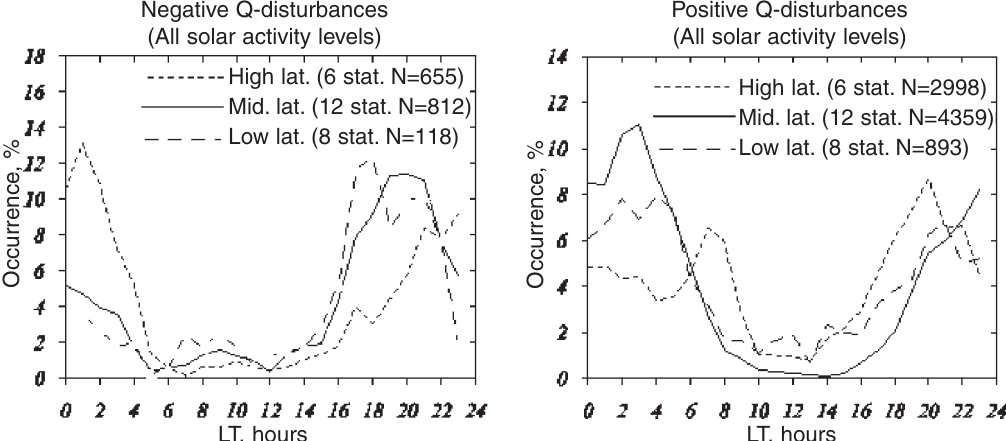
Fig. 11. Occurrence of negative and positive Q -disturbances versus local time for high, middle, and lower lat- itude stations. Total number of stations and events are given in